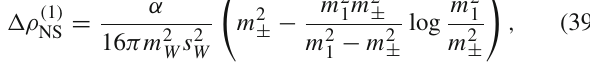
m Z (cid:2) / 2 through the s -channel ψ at the nonresonant region through the t -channel ψ and the Higgsstrahlung ψ